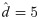
Phylogenies simulated on time-integrated static skewed-clustered networks.We compare trees from outbreaks on networks with mean degrees d^=5 and d^=9 for infection rates β = 0.05 and β = 0.1. All trees have 500 tips. Simulated trees to this figure are found in S2 File.